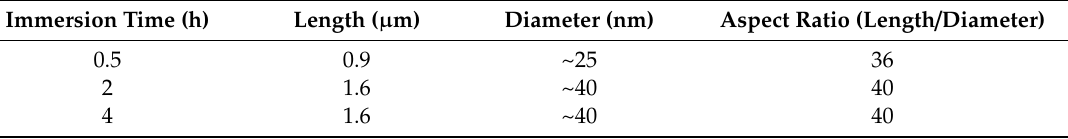
Table 2. The summary of length and diameter of prepared ZnO NRs at di ff erent immersion time. Immersion Time